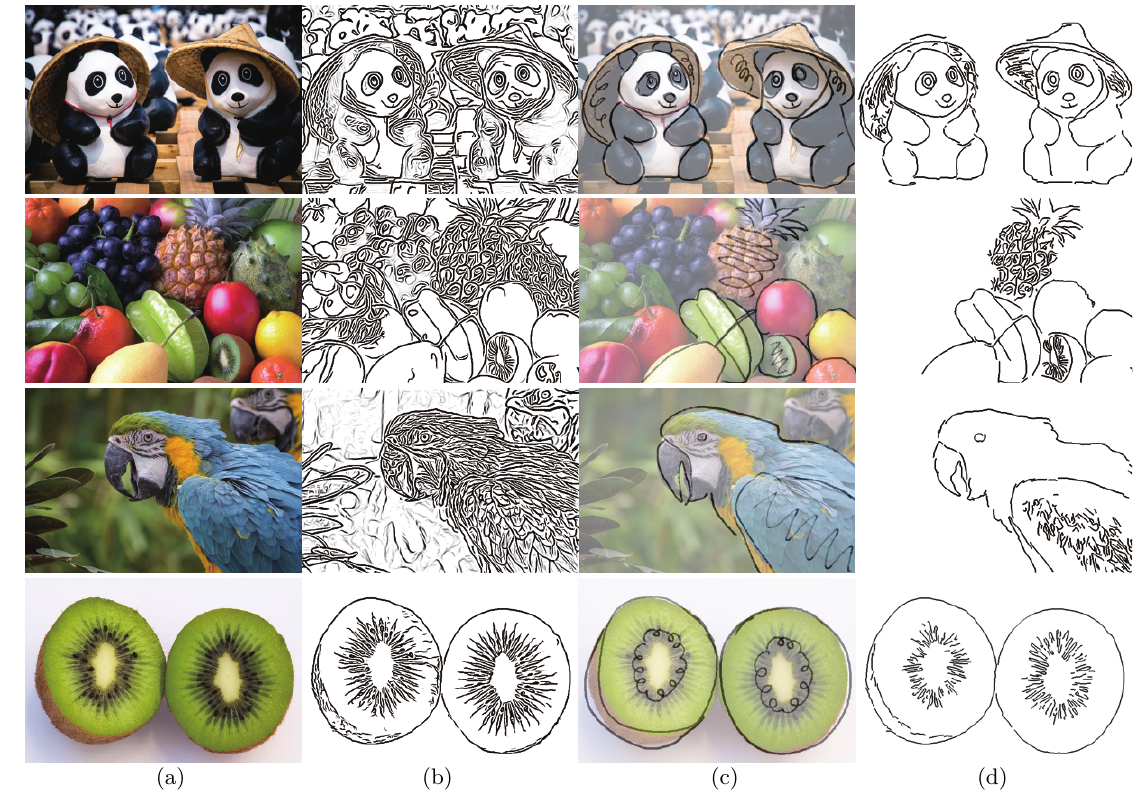
Fig. 9 Four results generated using our system. (a) Input image. (b) Detailed line drawings by fDoG [2]. (c) User strokes. (d) Final line abstractions.